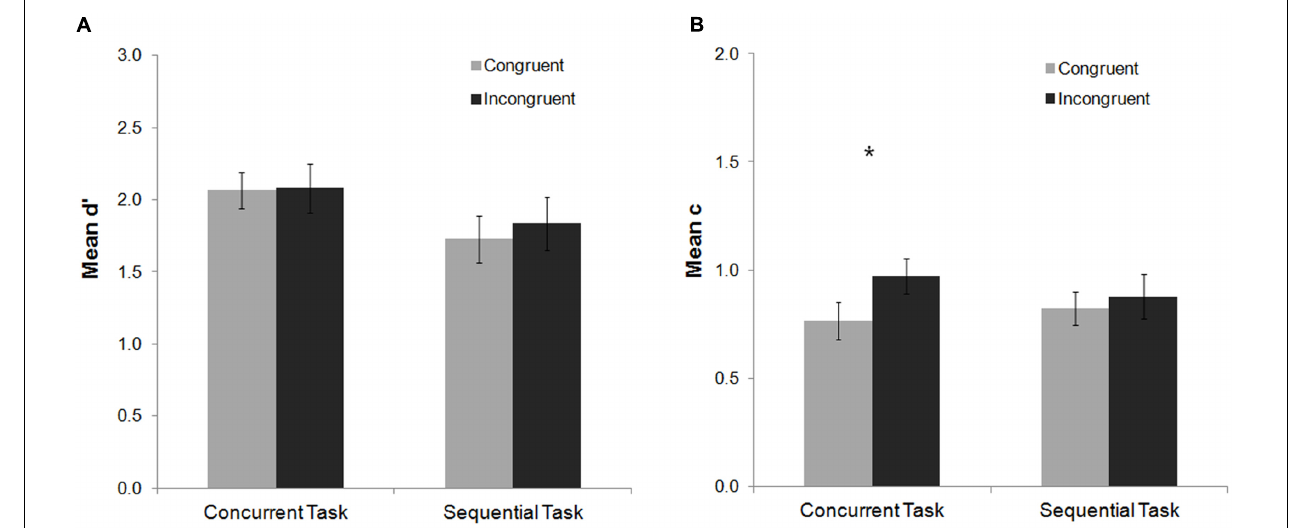
FIGURE 2 | Mean d (cid:48) and c indexes as a function of task and Stroop congruency in Experiment 1. No significant effects were observed on the analysis of the mean d (cid:48) index (A) . For the mean c index (B) participants maintained a more conservative response criterion for incongruent than congruent trials, especially on the concurrent task, although the interaction between task and congruency was not significant (see Results). Bars represent standard errors. Asterisks represent significant effects for the Fisher post hoc comparisons ( p <